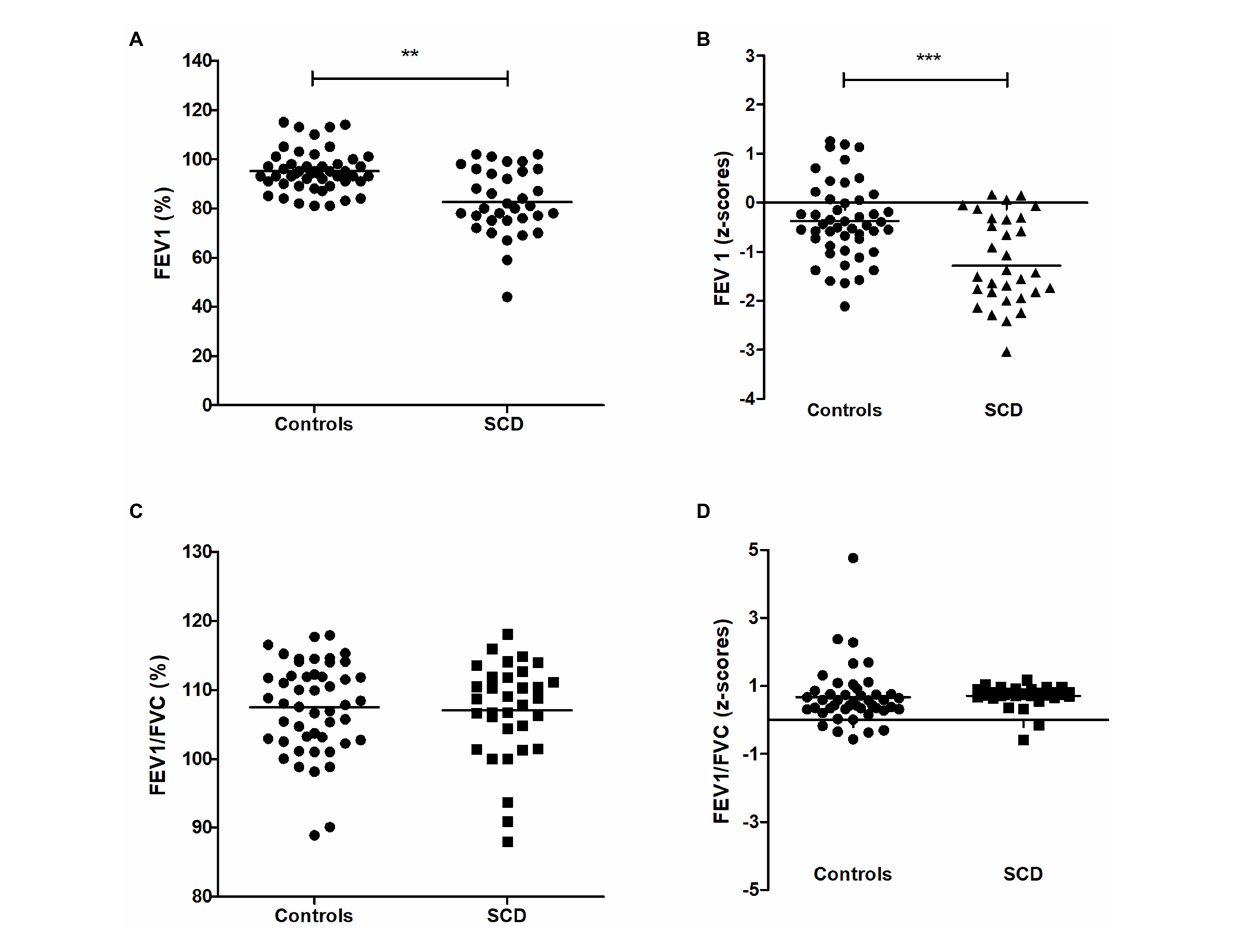
FIGURE 1 FEV1 of SCD patients and controls (A) Percent predicted forced expiratory volume during the first-second (FEV1 in %), (B) FEV1 (z-scores), (C) FEV1/FVC ratio, (D) FEV1/FVC ratio (z-scores). *** p < 0.001, ** p <